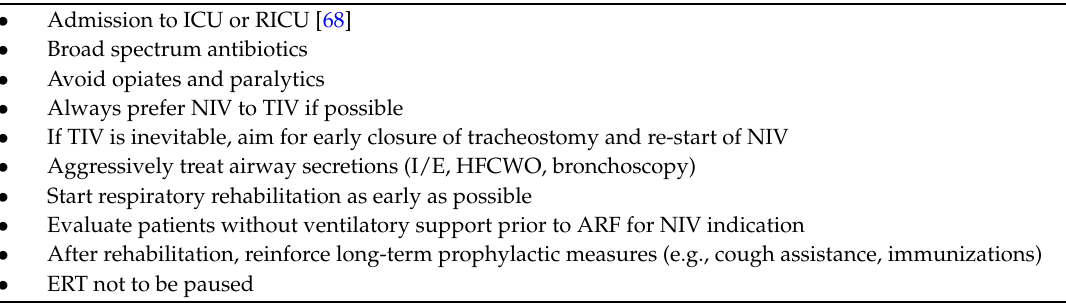
Table 4. Management of acute respiratory failure (ARF) in patients with LOPD. ERT, enzyme